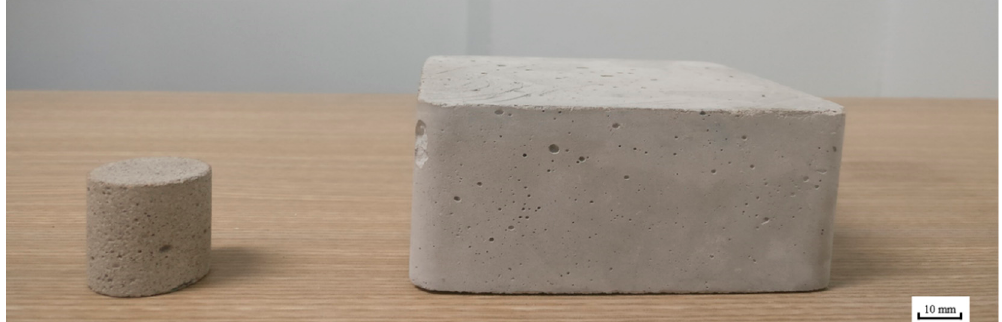
Table 1. Mechanical properties of the mortar sample.